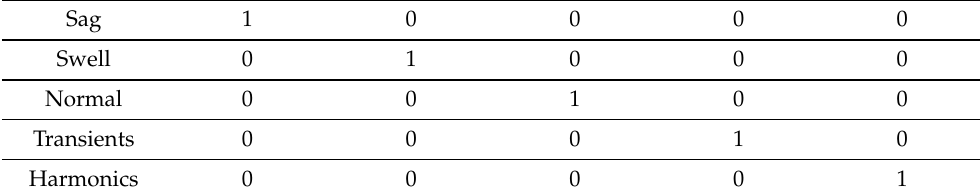
Figure 4. Analysis of detailed coefficients of HAAR Wavelet with different PQ events. Table 2. Binary Classification for PQ event